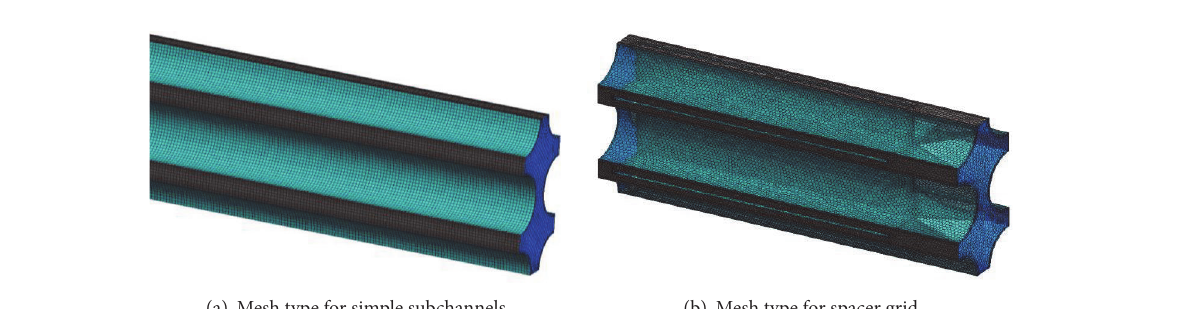
Figure 13: Mesh scheme for each region.